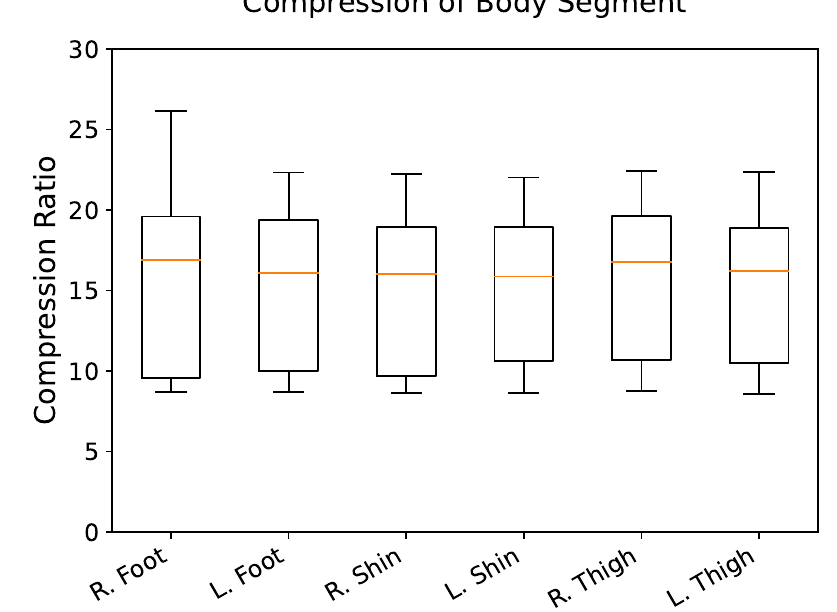
Figure 5. Distribution of compression ratio (original size/compressed size) of each body segment using delta encoding. All body segments achieved similar